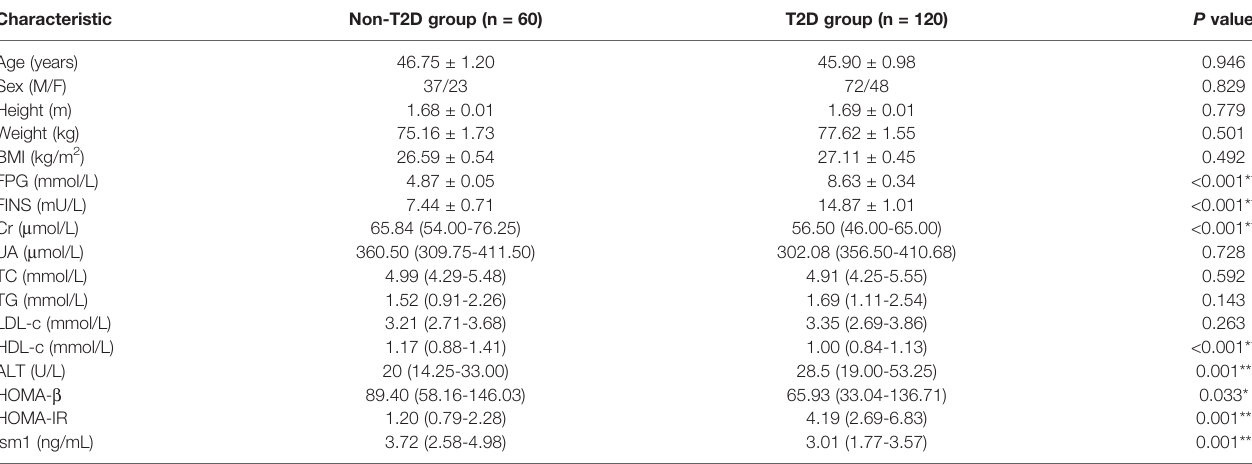
TABLE 1 | Clinical characteristics of the non-diabetic control group and T2D group.